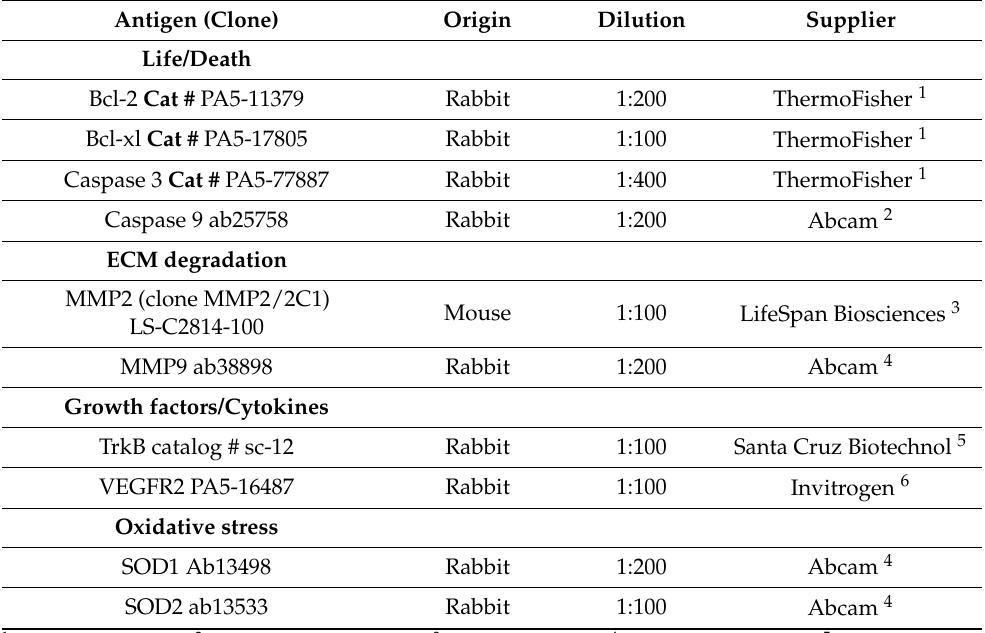
Table 2. Antibodies used in the